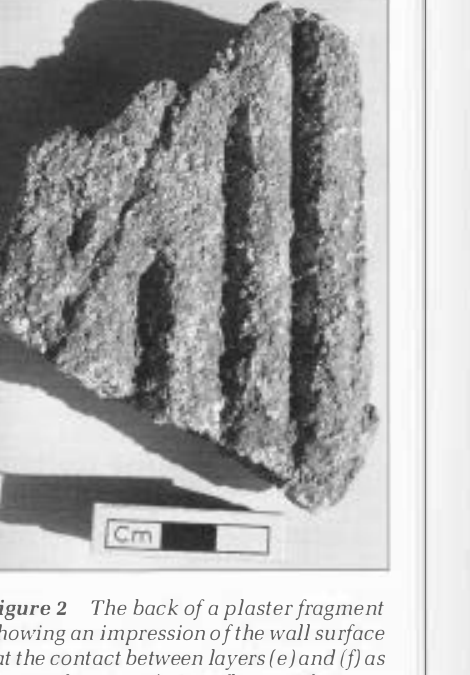
Figure 2 The back of a plaster fragment showing an impression of the wall surface (at the contact between layers (e) and {f) as depicted in Fig. 4}, Penaflor, southern